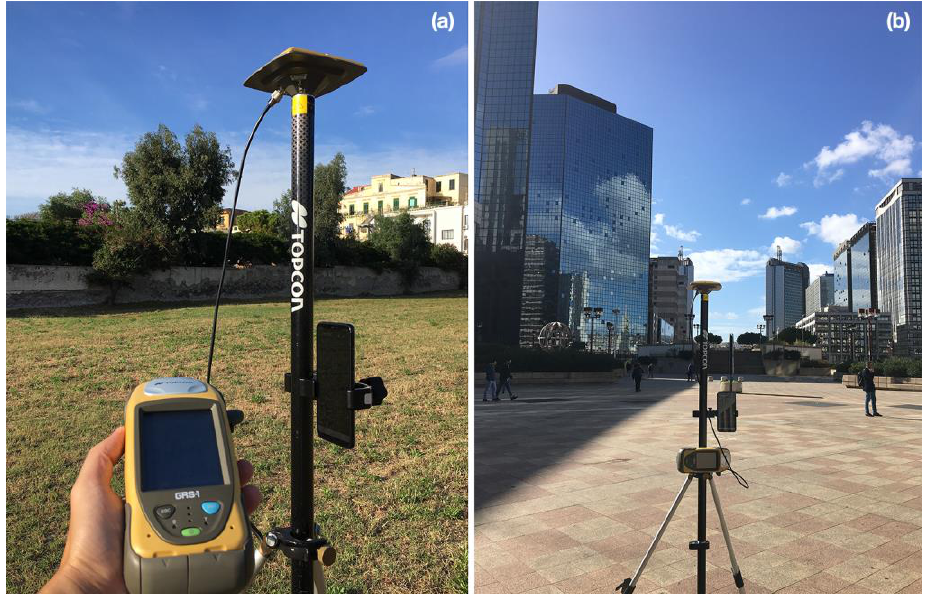
Figure 1. The location where the two sets of experimental data were collected, and the equipment used in this study: ( a ) Portici site, ( b ) Centro Direzionale Napoli (CDN)